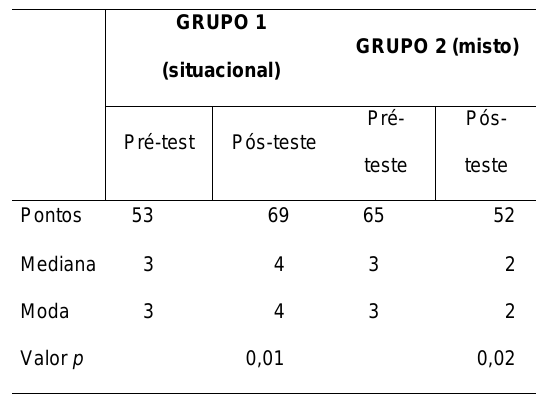
Tabela 3. Resultado do pré-teste e do pós-teste para conhecimento tático processual KORA: OO divergente